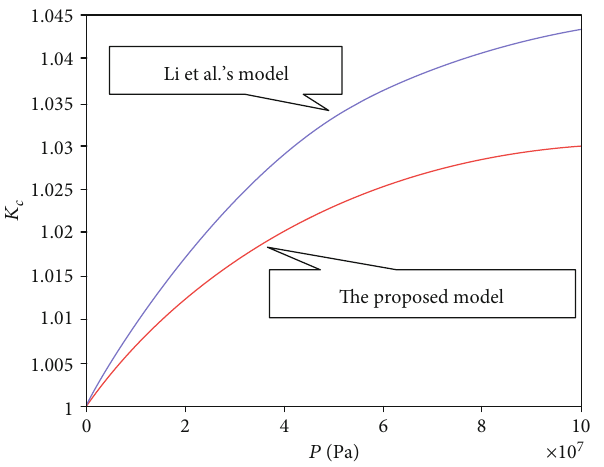
Figure 7: Comparison of gas apparent permeability enhancement factor K C with Li et al. ’ s model [22]. T = 300 K, h = 5 nm , L = 0 : 0723 m, θ = 30 ° . 0 : 3nm , r 0